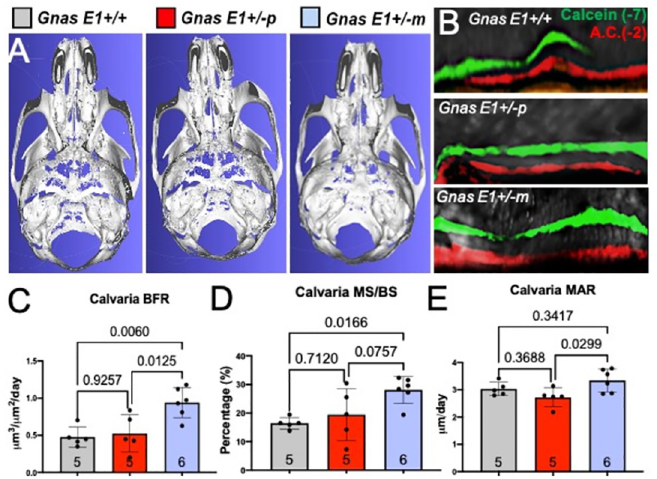
Fig 8. Gnas E1+/-m mice display cranial hyperostosis and enhanced calvarial bone formation in vivo . (A) Representative 3D reconstruction of the cranial vault of 12-week WT, Gnas E1+/-p, and Gnas E1+/-m mice demonstrating hyperostosis within Gnas E1+/-m mice. (B) Representative calcein and alizarin complexone double labeling on the calvaria of 12-week WT, Gnas E1+/-p, and Gnas E1+/-m mice. (C-E) Quantification of (C) Bone formation rate (BFR); (D) mineralizing surface to bone surface (MS/BS); and (E) Mineral apposition rate (MAR) within the calvaria demonstrates Gnas E1+/-m mice display enhanced bone formation when compared to both WT and Gnas E1+/-p mice. No significant differences were observed between WT and Gnas E1+/-p mice. Sample size per genotype per experiment is listed on each graph. All statistical tests were completed using ANOVA with post-hoc Tukey test for multiple comparisons, and p -values are displayed for each